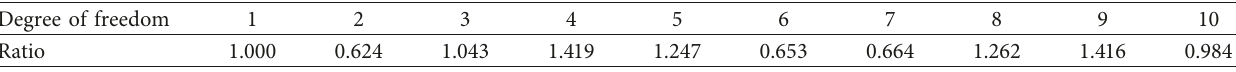
Table 5: The ratios of the 2 norms of the acceleration of all degrees of freedom to that of degree of freedom 1.